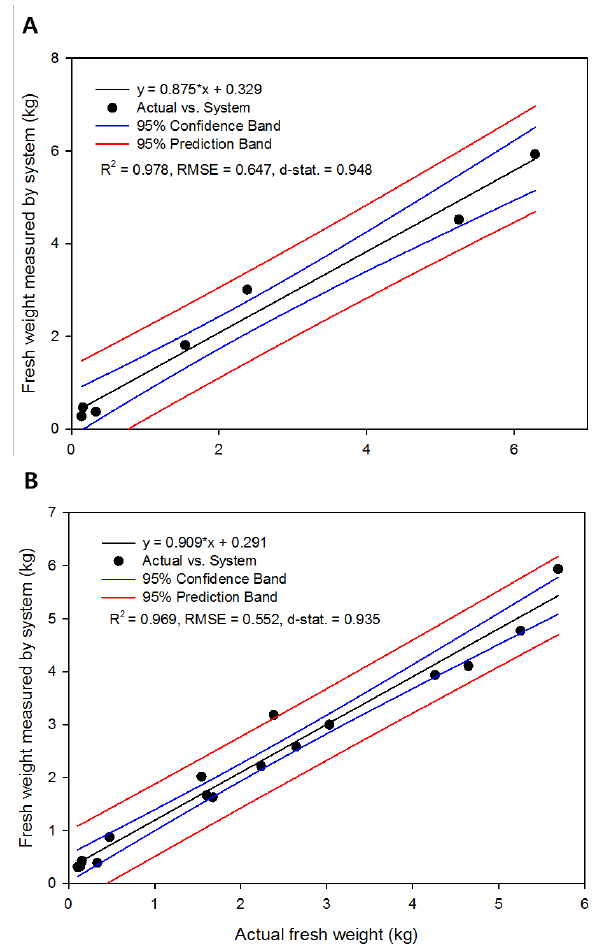
Figure 7. Comparison of crop fresh weights measured by the developed system and the actual measurements by the growth survey (dot) and the linear regression (black line). ( A ) and ( B ) indicate growth periods 1 (8 February–28 May 2018) and (30 October 2018–25 March 2019), respectively.